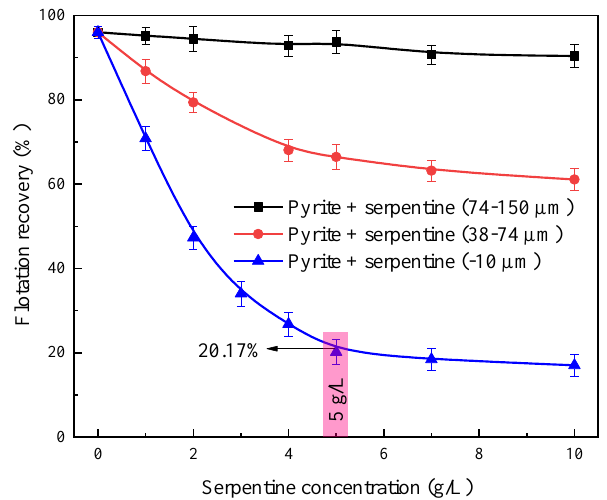
Figure 3. Effect of serpentine with different size fractions on pyrite flotation as a function of serpentine concentration (pH = 9).